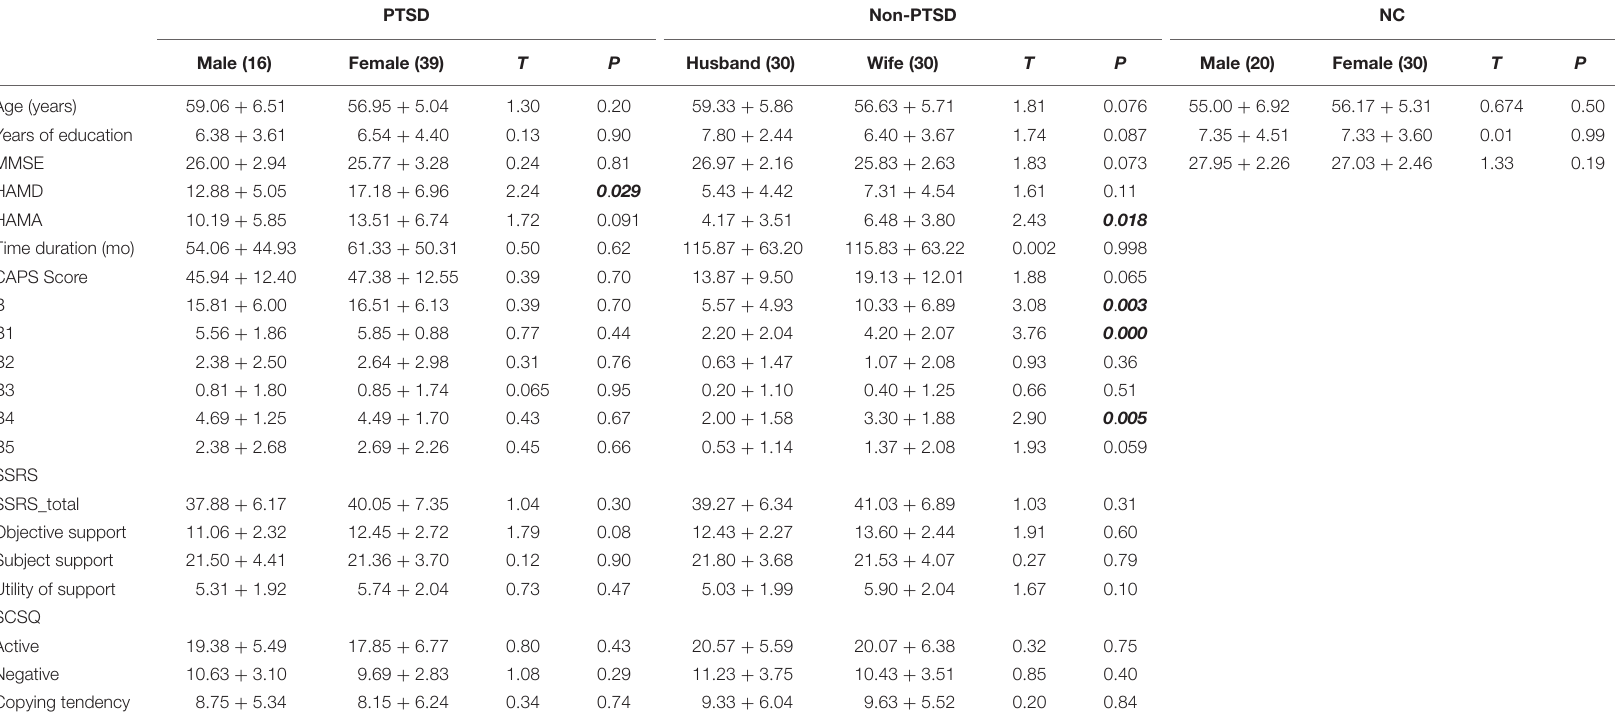
TABLE 1 | Demographic data and clinical comparisons between male and female within